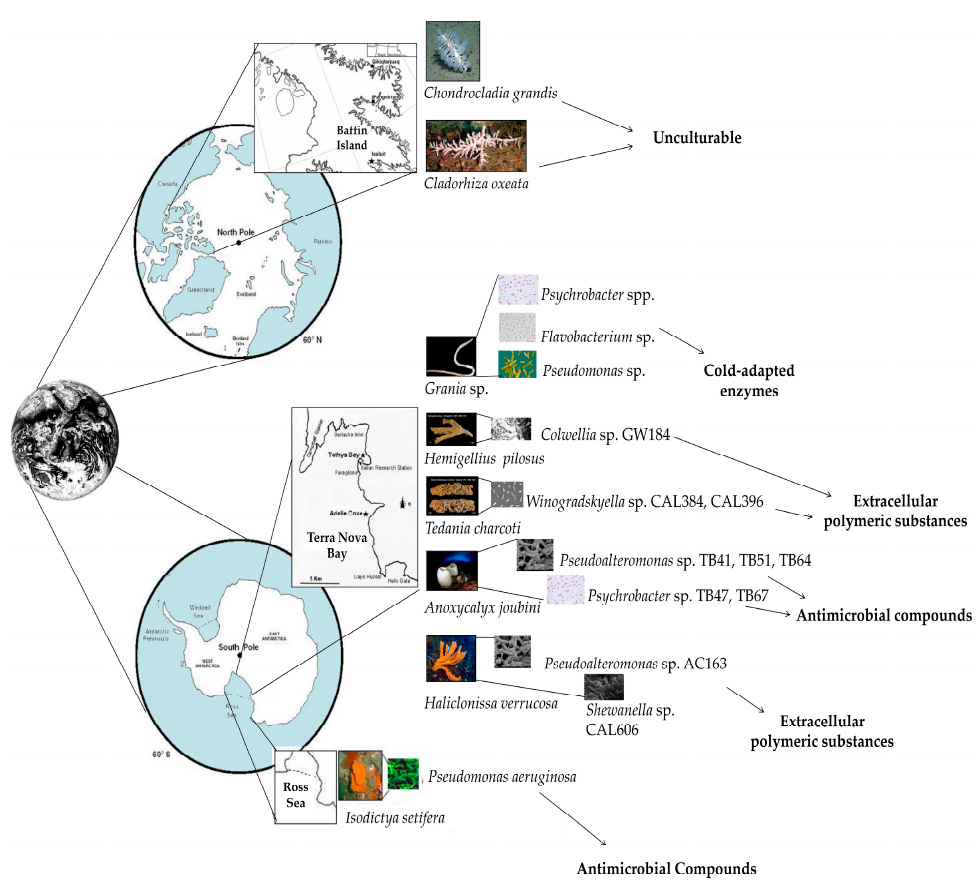
Figure 1. Polar benthic invertebrates as a source of bacterial diversity and biodiscovery. A number of studies have demonstrated that cold-adapted bacteria from Antarctic invertebrates produce bioactive compounds (e.g., enzymes, extracellular polymeric substances, and molecules with antimicrobial activity). To date, cold-adapted bacteria from Arctic holobionts have only been explored for biodiversity.